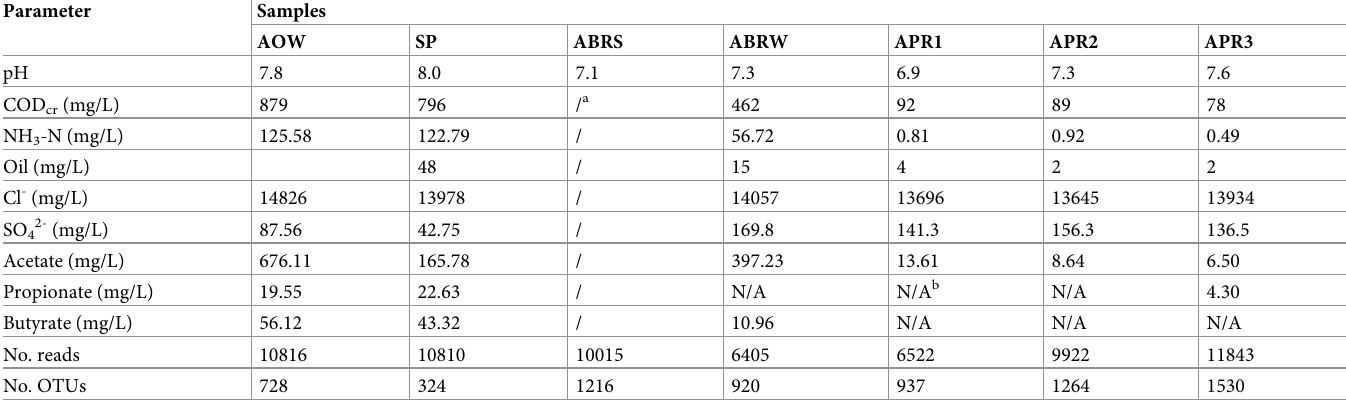
Table 1. Summary of water quality, numbers of reads and OTUs in samples of the full-scale offshore produced water treatment plant. Parameter